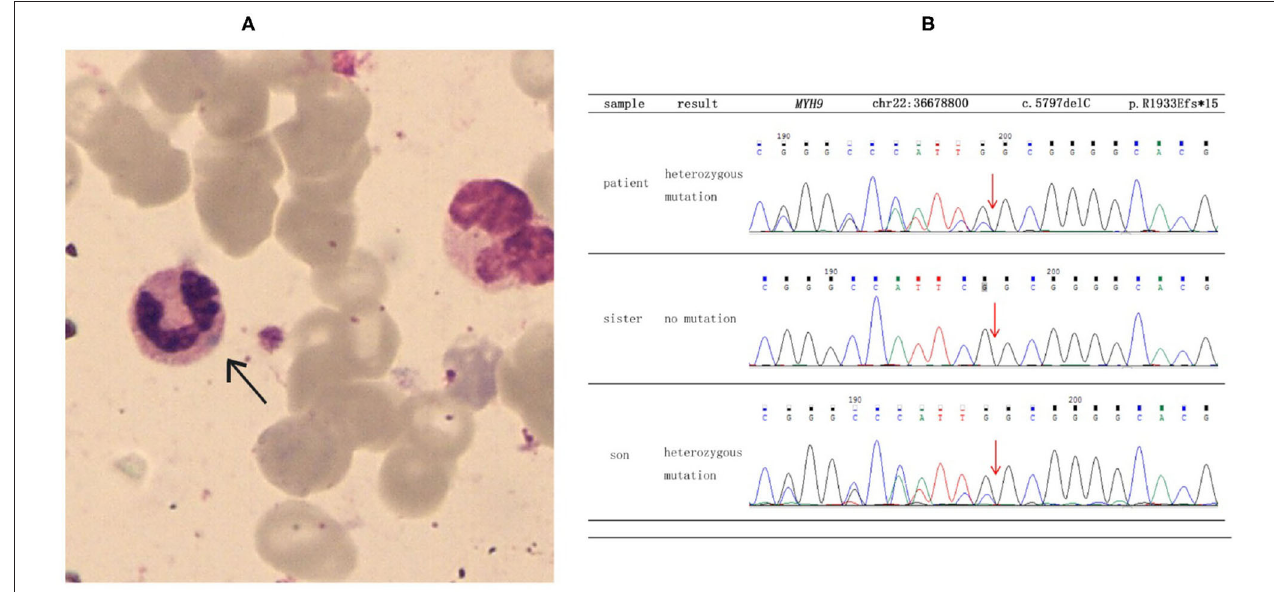
FIGURE 1 | Results of blood smear and direct sequencing. (A) The black arrow indicates inclusion bodies in the neutrophils on the blood smear (Wright–Giemsa staining). (B) The results of direct sequencing of MYH9 exon 41 in the proband and other family members. The proband and her son were both heterozygous for a deletion mutation of c.5797delC, which then led to a frameshift mutation and caused a prematurely truncated protein p. R1933Efs*15.